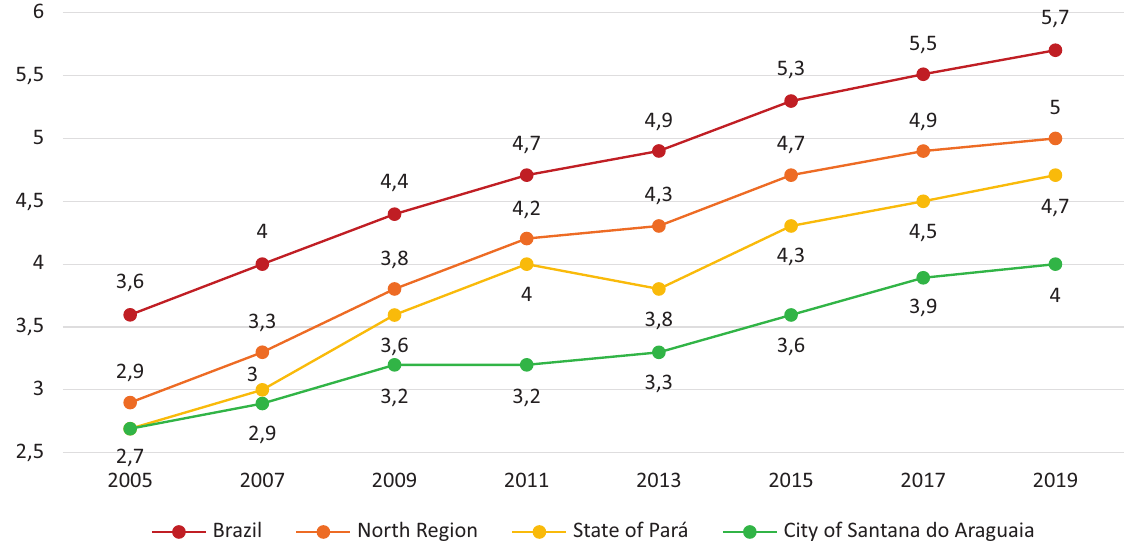
Figure 3. IDEB in the early years of elementary school in the public network. Source: INEP (2021).